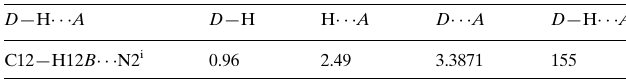
Hydrogen-bond geometry (A˚ , (cid:2)